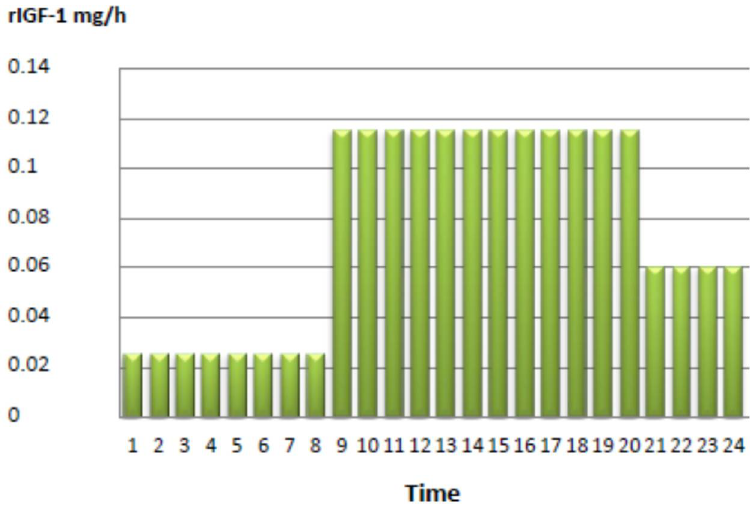
Figure 1. Mecasermin delivery in mg/h via an insulin pump in the reported patient.